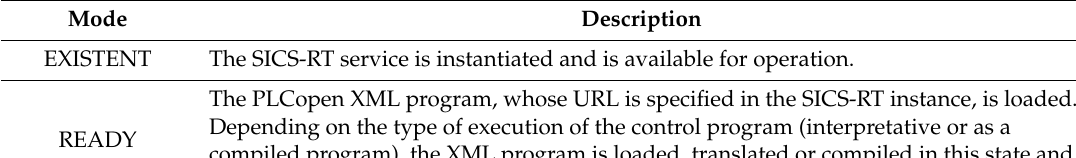
Table 2. Operating modes of a SICS runtime.